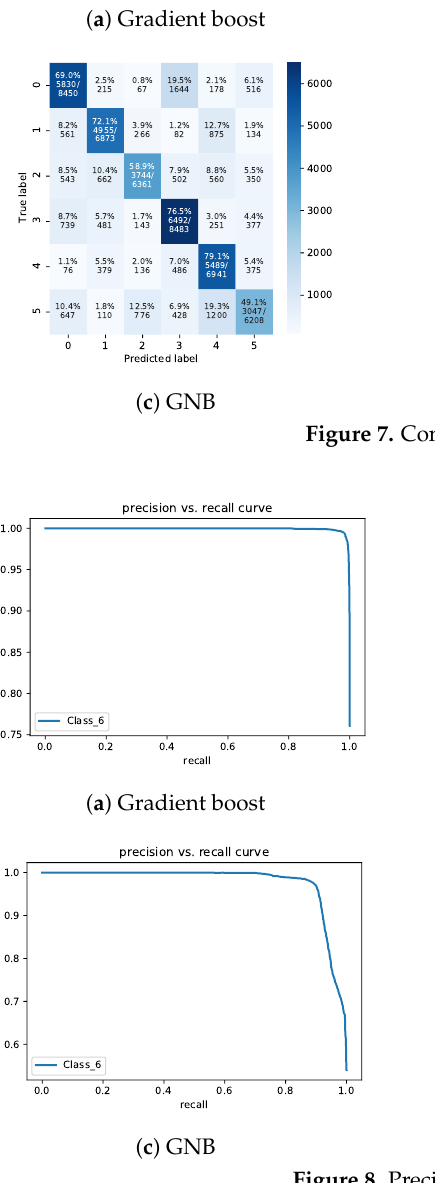
Figure 8. Precision–recall curves for